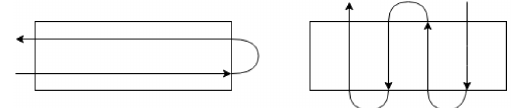
Figure 2. The number of turns, depending on the direction of the lanes.